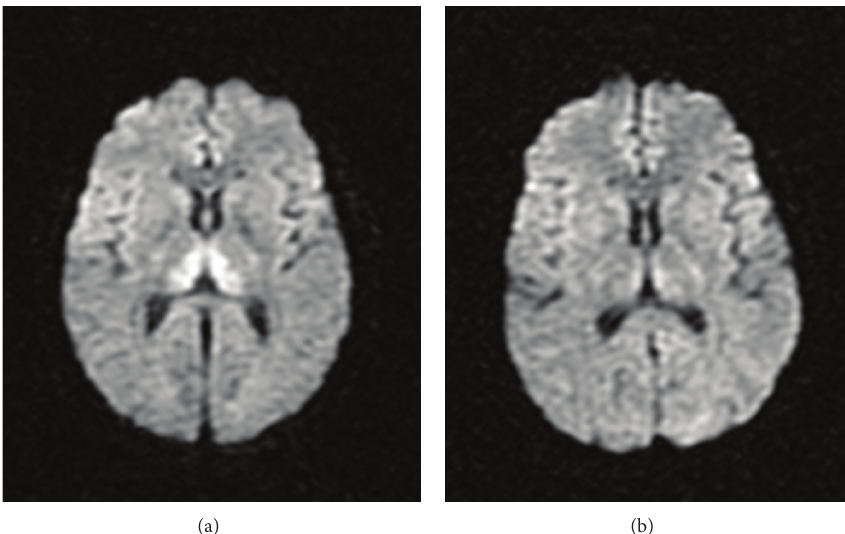
Figure 3: Corresponding DWI MRIs showing bilateral thalamic signal abnormalities one day (a) and seven days (b) after admission.